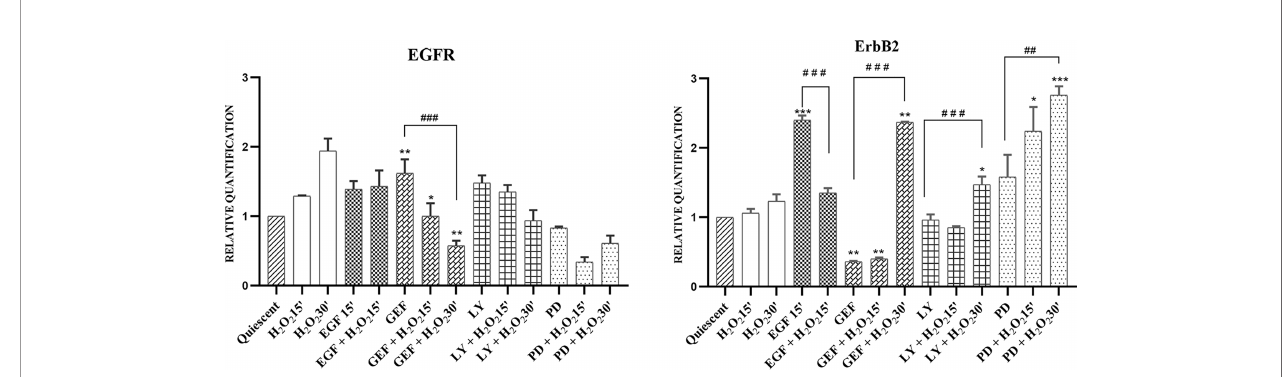
FIGURE 4 | mRNA expression of EGFR and ErbB2 in AGS cells. Total RNA was extracted from serum-starved cells untreated (Quiescent) and treated with 50 ng/ mL EGF, 1 m M ge fi tinib (GEF), 25 m M LY294002 (LY), 50 m M PD98509 (PD), and/or 10 mM H 2 O 2 , for 15 and 30 min. Analysis was carried out by RT-qPCR. As for gene expression analysis, data were calculated using the 2 − DD Ct method, normalized to GUSB ( b -glucuronidase) mRNA levels, and expressed relative to control (calibrator sample, de fi ned as 1.00). Data are expressed as means of three independent experiments. *p < 0.05; **p < 0.01; ***p < 0.001 (student ’ s t-tests, vs quiescent cells); ## p <0.01; ### p<0.001 (ANOVA followed by Bonferroni post-hoc test, within treatments). GEF, ge fi tinib; LY, LY294002; PD,